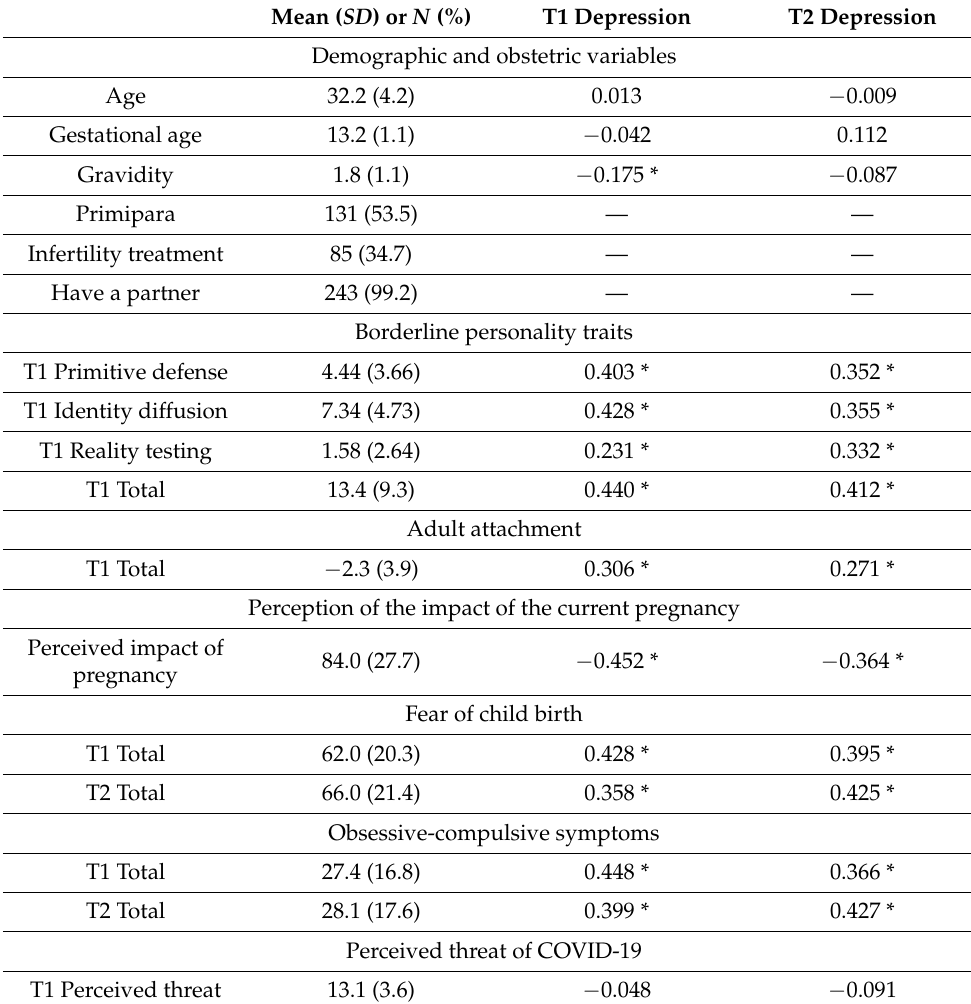
Table 1. Correlations of T1 and T2 depression ( N =